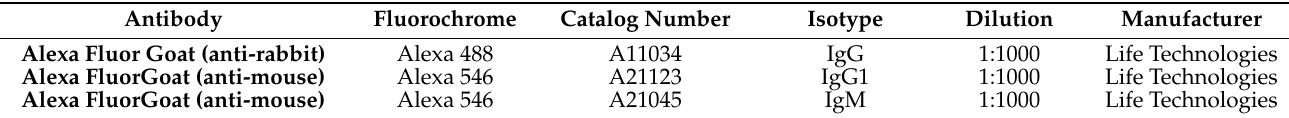
Table 3. Secondary antibodies used for the